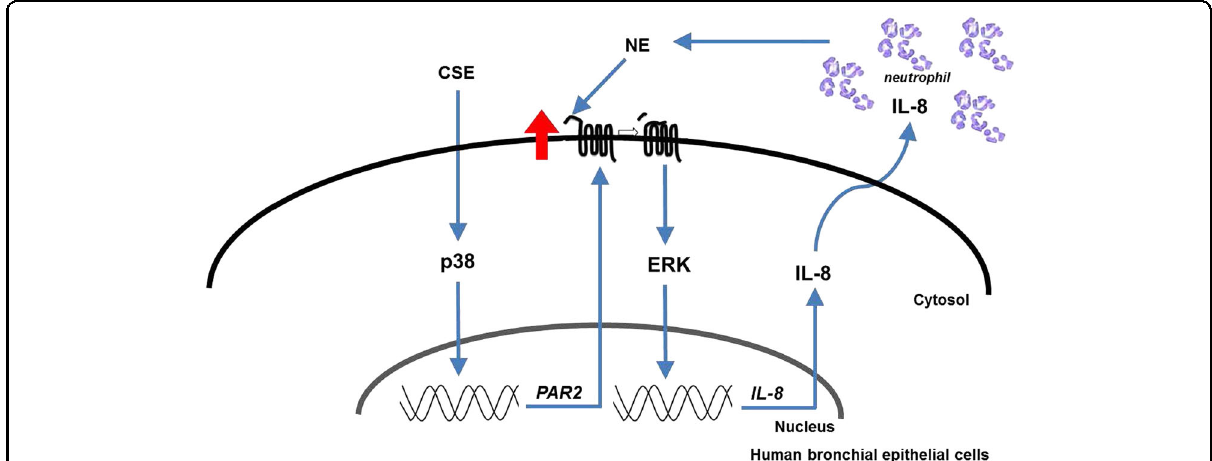
Fig. 6 Schematic diagram of the cross-talk between CSE and NE. CSE increases IL-8 production in lung epithelial cells. Released IL-8 recruits neutrophils into the lungs. Neutrophils secrete several proteases including NE. NE induces IL-8 production via the PAR2-mediated activation of ERK. CSE upregulates PAR2 through a p38-dependent pathway, which enhances NE-induced IL-8 production. A vicious cycle causing continued neutrophil accumulation and in fl ammation